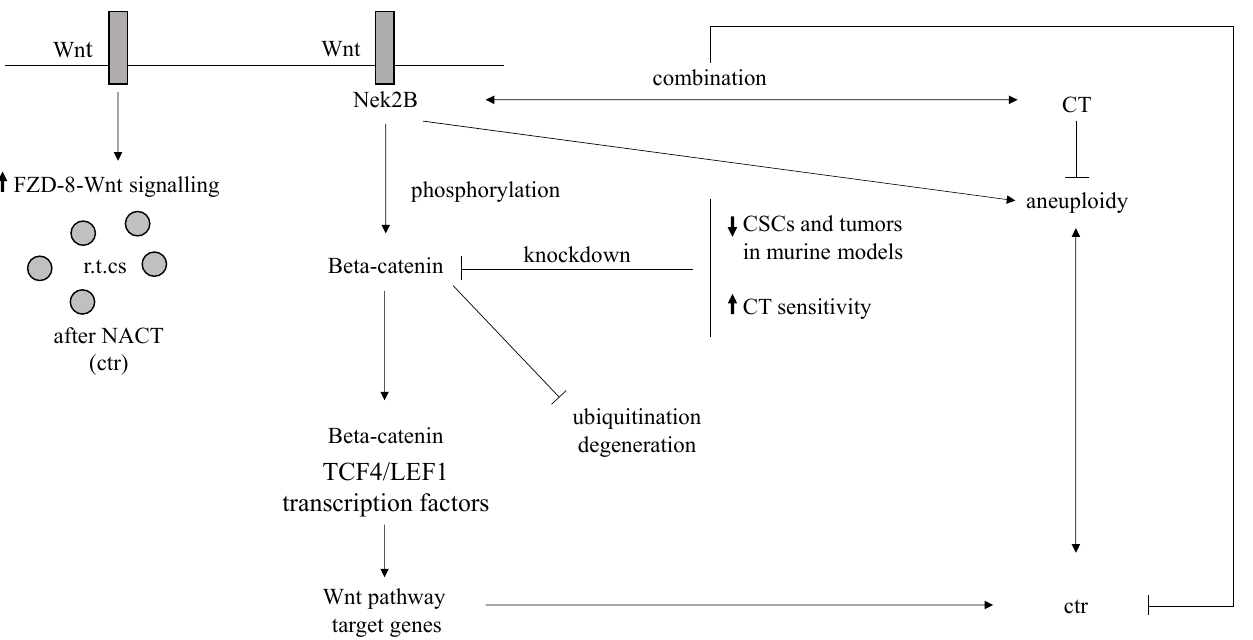
Figure 2. Wnt-beta-catenin pathway. Potential mechanisms of chemotherapy resistance (ctr) in TNBC. FZD-8: Frizzled-8; NEK2B: NIMA related kinase 2; CSCs: cancer stem cells; CT: chemotherapy; TCF: T cell factor; LEF: lymphocyte enhancer factor; r.t.cs: residual tumor cells; NACT: neoadjuvant chemotherapy. ↑ increase; ↓ decrease. Also see text.